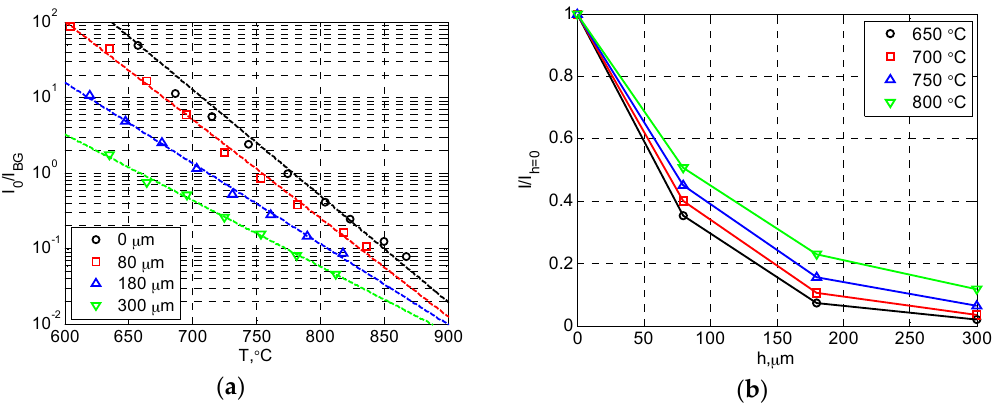
Figure 8. Effects of YSZ topcoat thickness on SBR: ( a ) temperature vs. SBR; ( b ) topcoat thickness ( h ) vs. signal attenuation ( I / I h =0 ).